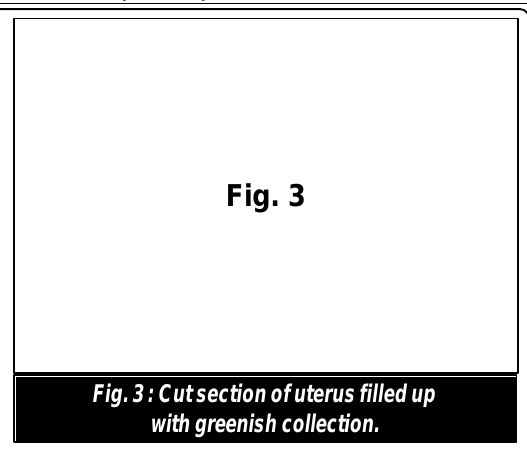
Fig. 3 : Cut section of uterus filled up with greenish